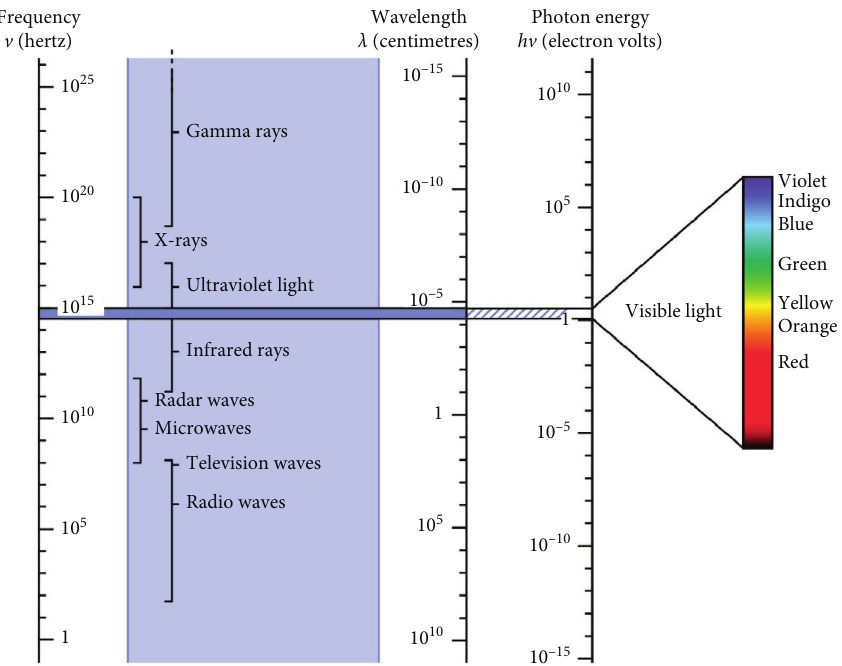
Figure 1: The electromagnetic